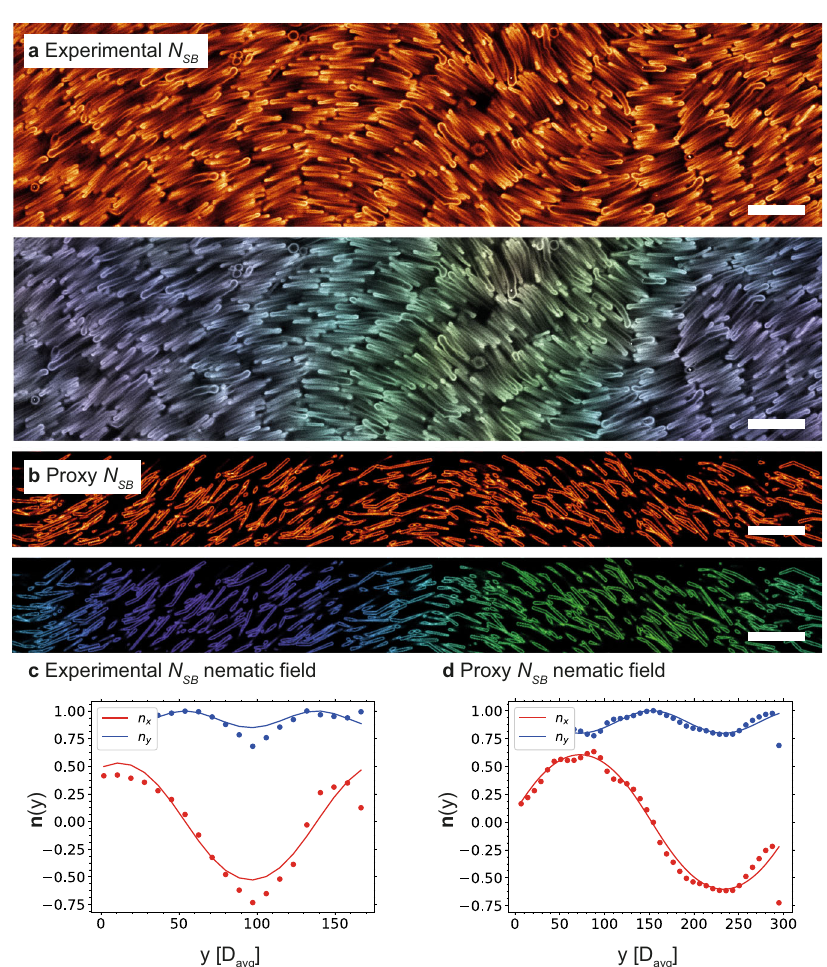
Fig. 3 | Characterization of the N SB phase. a Fluorescence confocal microscopy image of a N SB domain located between the previously identi fi ed N and Sm phases (between4±1 μ mand8±1 μ mfromthebottomsurface). b Proxy,computationally generated fl uorescenceconfocalmicroscopyimageofadispersionof rodsina N SB con fi guration. c Characterization of the nematic director fi eld of the experimental N SB phase. The extracted values were p =86.2±11.7 μ m and θ 0 =0.46±0.01rad. Spatial coordinates are given in terms of the average diameter of the particles